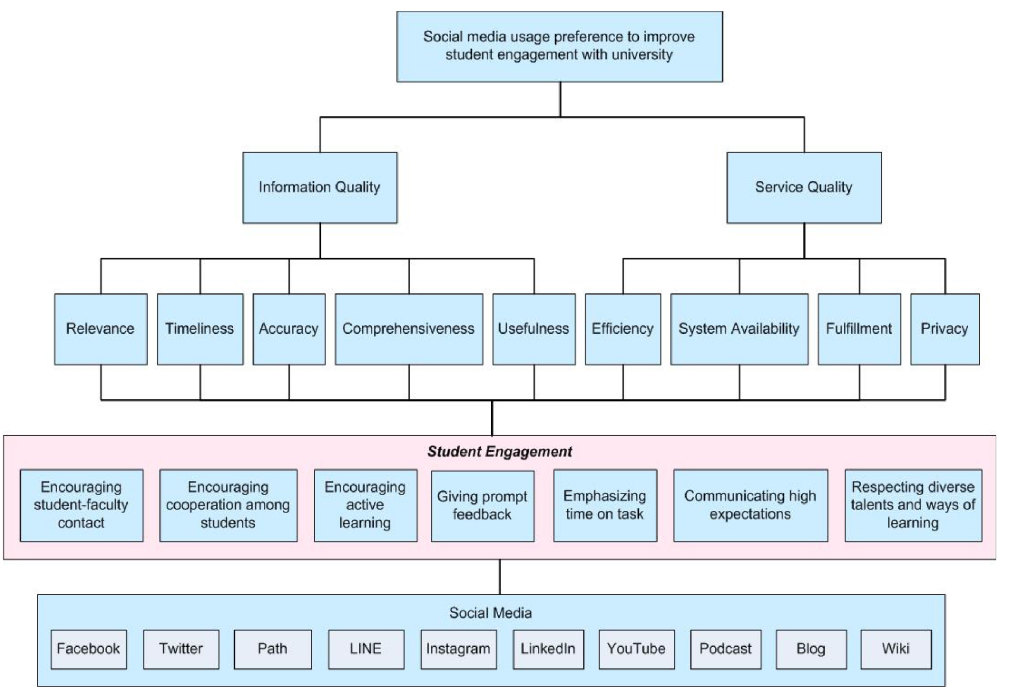
Figure 2. Hierarchy of social media usage